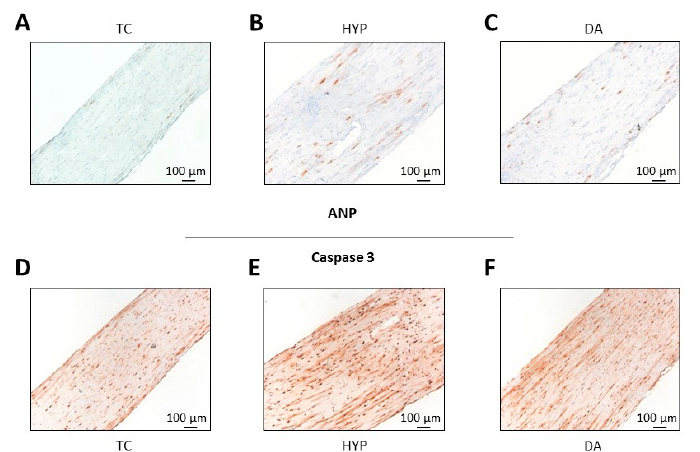
Figure 5. E ff ect of preconditioning with [ d -Ala2, d -Leu5]-Enkephalin (DADLE, 100 nM, 3 × 10 min, DA), followed by 90 min hypoxia compared to the hypoxic group without preconditioning (HYP) and to the control group without hypoxia (time control, TC). ( A – C ) Atrial natriuretic peptide (ANP)-stained para ffi n section of the EHT in a longitudinal view. ( A ) 5.0 ANP + cells / mm 2 in TC, ( B ) 31.1 ANP + cells / mm 2 in HYP, ( C ) 15.0 ANP + cells / mm 2 in DA. ( D – F ) Active Caspase 3 (subunit p17)-stained para ffi n section of EHTs in a longitudinal view. ( D ) 37.7 Casp-3 + nuclei (dark brown) / mm 2 in TC, ( E ) 222.2 Casp-3 + nuclei / mm 2 in HYP, ( F ) 43.1 Casp-3 + nuclei / mm 2 in DA. Nuclei in ( A – F ) were lightly